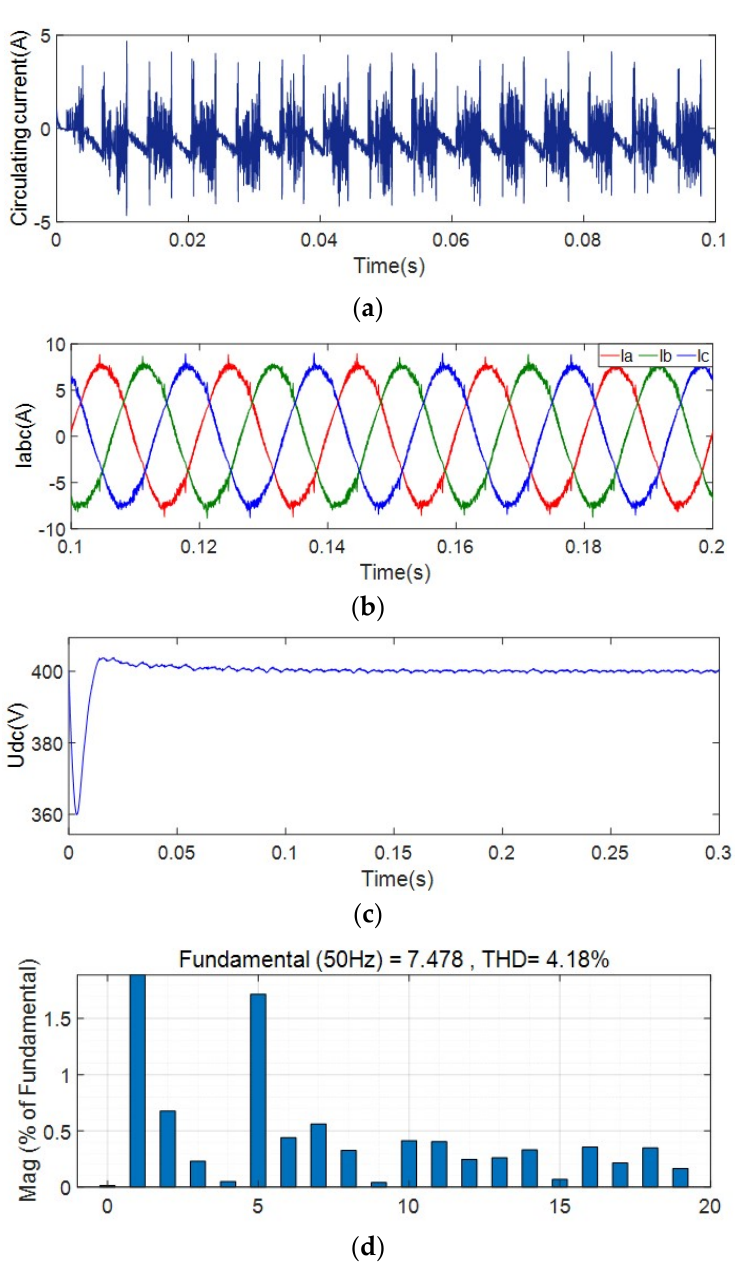
Figure 11. In the case of different AC side inductance parameters, no circulating current suppression control scheme is added ( a ) Positive DC bus circulating current. ( b ) AC side current. ( c ) DC side output voltage. ( d ) THD of AC side current.